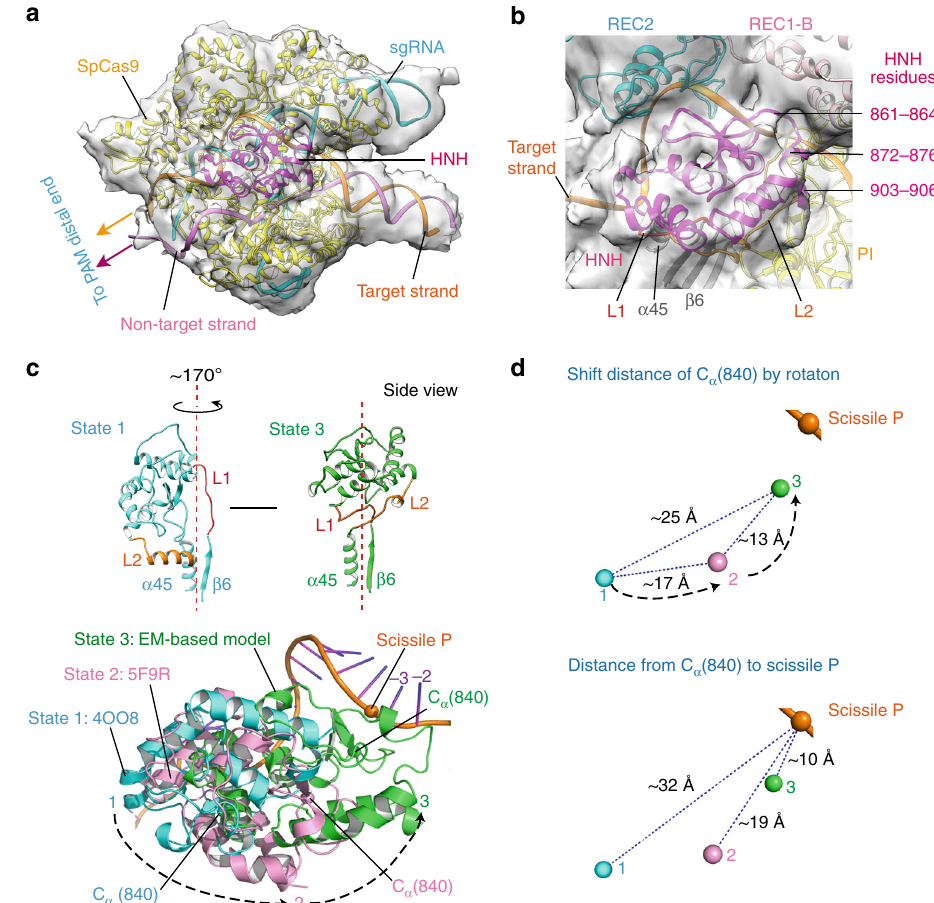
Fig. 3 The EM-based atomic model of the ternary complex. a The EM density-based atomic model with the 41-bp DNA target (in cartoon). The possible positions of two DNA strands of the PAM distal end are indicated by two arrows. b The close contacts of the HNH domain with the REC1 and PI domains. c Three rotational states of the HNH domain. d Different state distances from the C α atom of the catalytic residue 840 to the phosphorus of the scissile